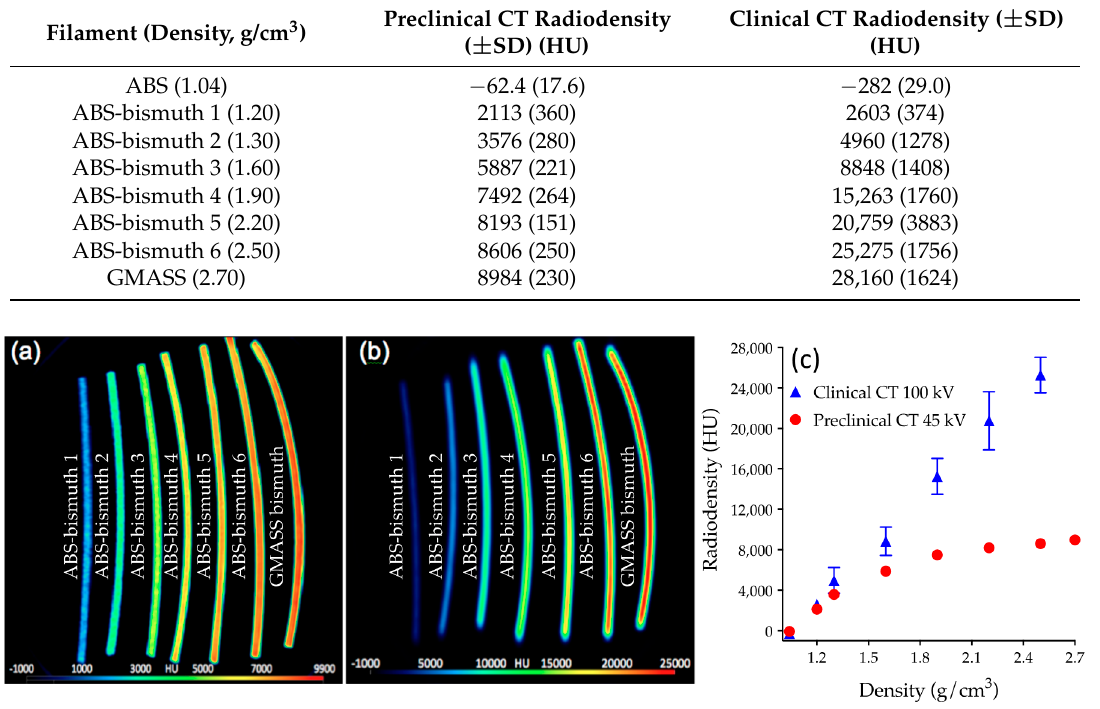
Table 2. Radiodensities of 3D-printed filaments. Filaments were imaged by both preclinical and clinical CT scanners and the images subsequently analyzed to obtain radiodensity values in HU.